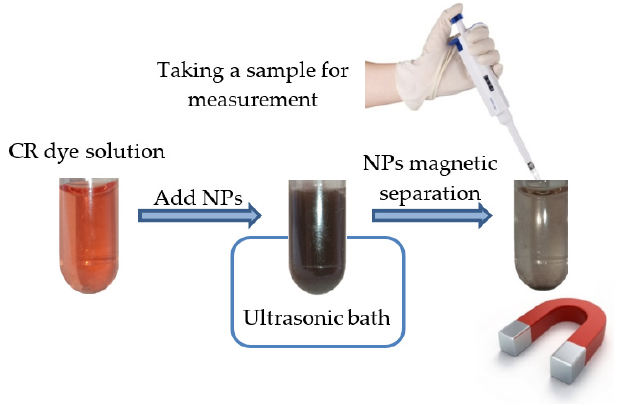
Figure 7. Schematic picture showing the preparation of a sample to measure the adsorption